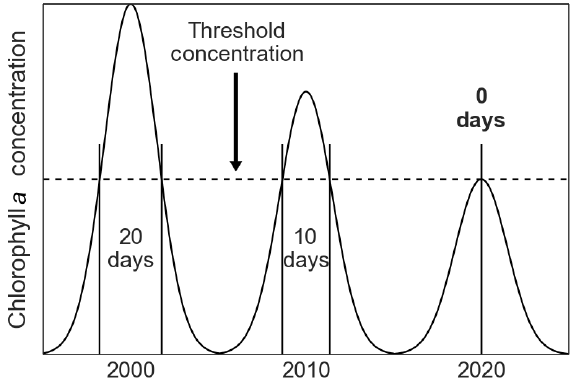
Figure 2. Transect of M/S Finnmaid and M/S Finnpartner through the Baltic Sea from Helsinki (Finland) to Travemünde (Germany; vice versa). The following sea areas are considered in this study: the western Gulf of Finland (gof: > 59.5 ◦ N latitude, along tran- sect), the northern Baltic Proper (nbp: 58.4–59.5 ◦ N latitude, along transect), the western and eastern Gotland basins (got: 56.2–58.4 ◦ N latitude, along transect), the southern Baltic Proper (sbp: 54.5– 56.2 ◦ N latitude, along transect) and the Bay of Mecklenburg (bom: < 54.5 ◦ N latitude, along transect). Depending on weather condi- tions, the north or south of Gotland routes were